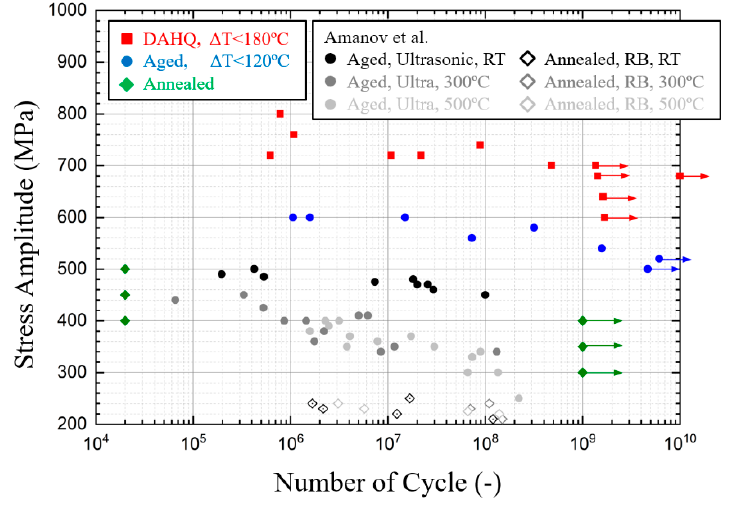
Figure 9. Comparison of VHCF properties with Amanov’s team [19].